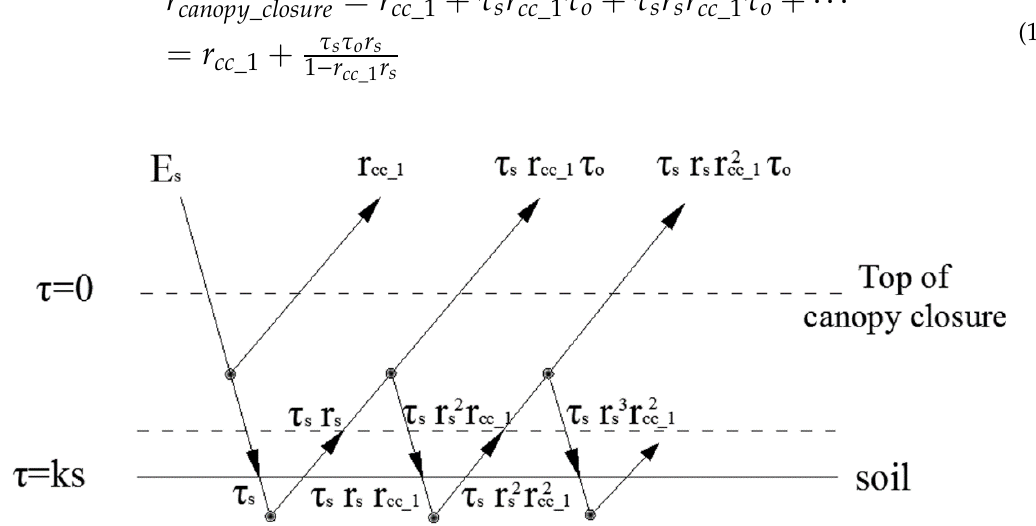
Figure 2. Sketch of radiative transfer inside an isotropic scattering layer and the soil. E s is the downward irradiance on the horizontal plane, r cc_ 1 is the single scattering contribution of the canopy closure, τ s is the transmittance of the canopy closure in the solar direction, and τ o is the transmittance of the canopy closure in the solar direction. τ is the optical thickness, k is the extinction coefficient, and s is the path length.